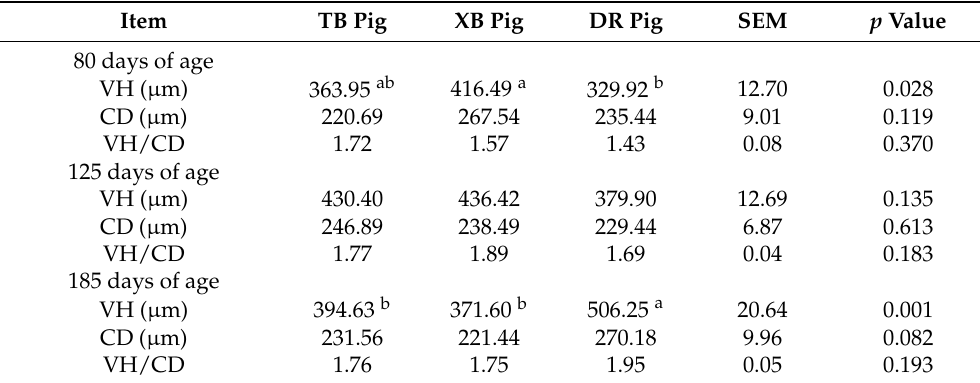
Table 8. Jejunal morphology of three pig breeds at different ages.